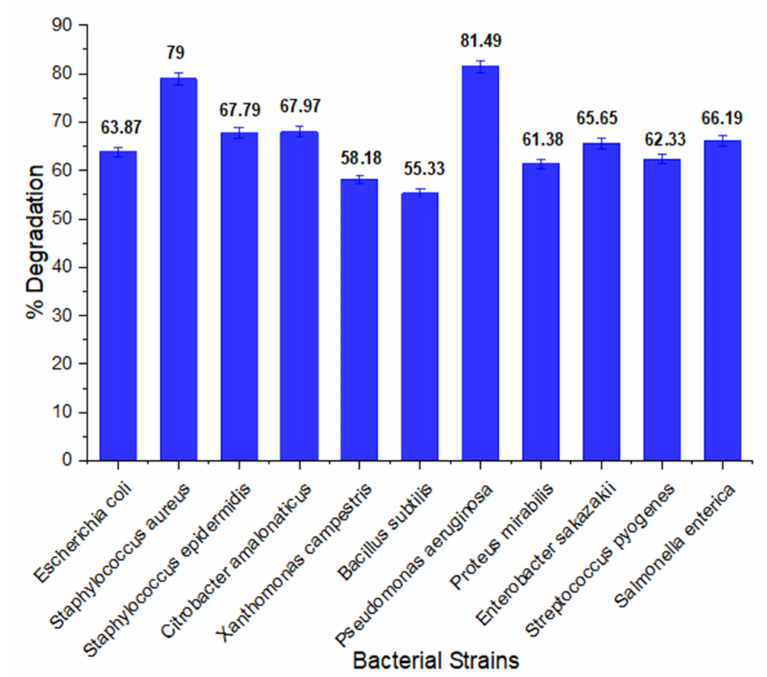
Figure 1. Percent degradation of methyl red by different